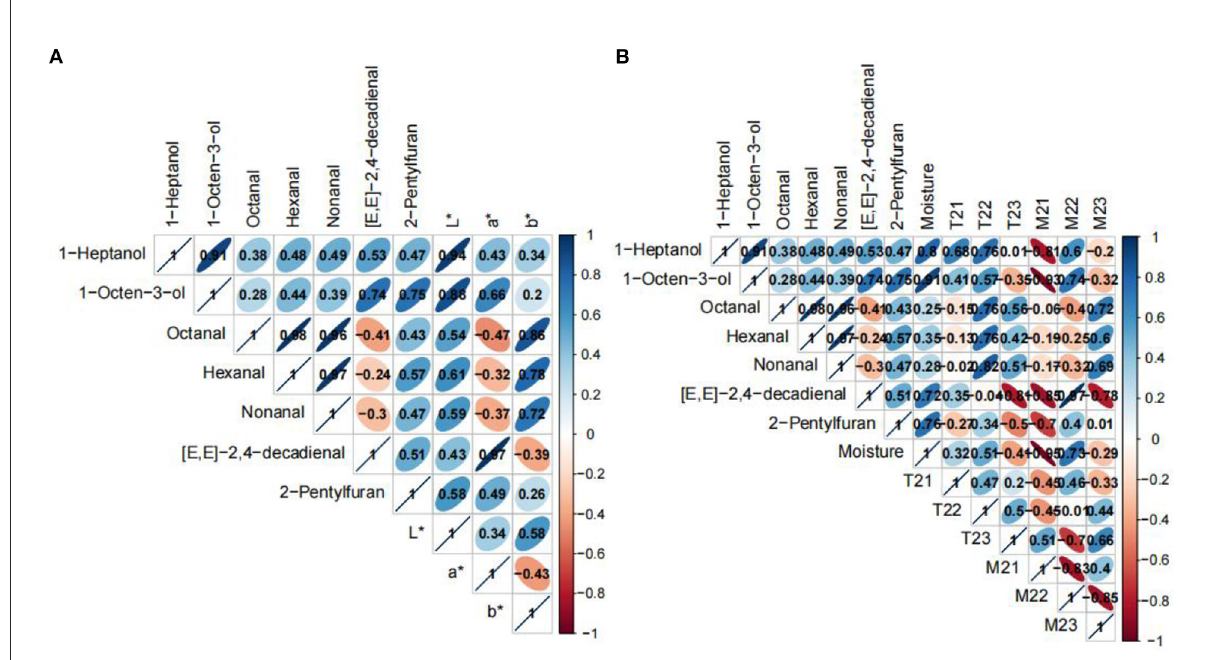
FIGURE5 Correlation analysis among color value (A) , water content (B) and key aroma